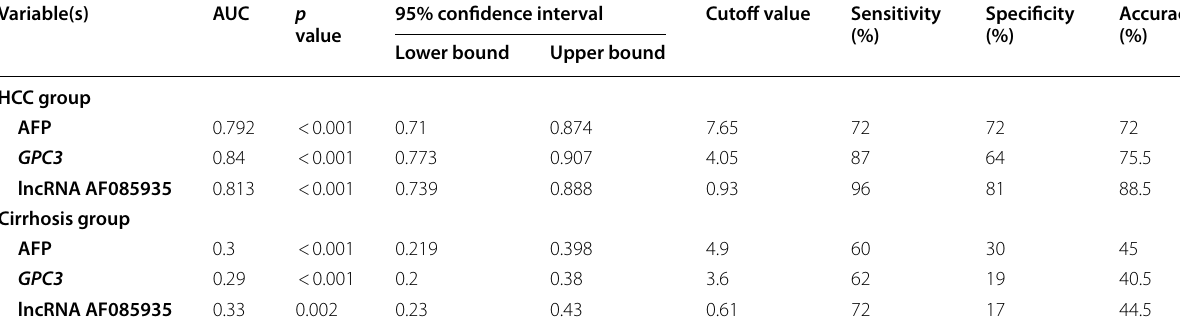
Table 3 Diagnostic accuracy of the different studied parameters for the HCC and cirrhotic